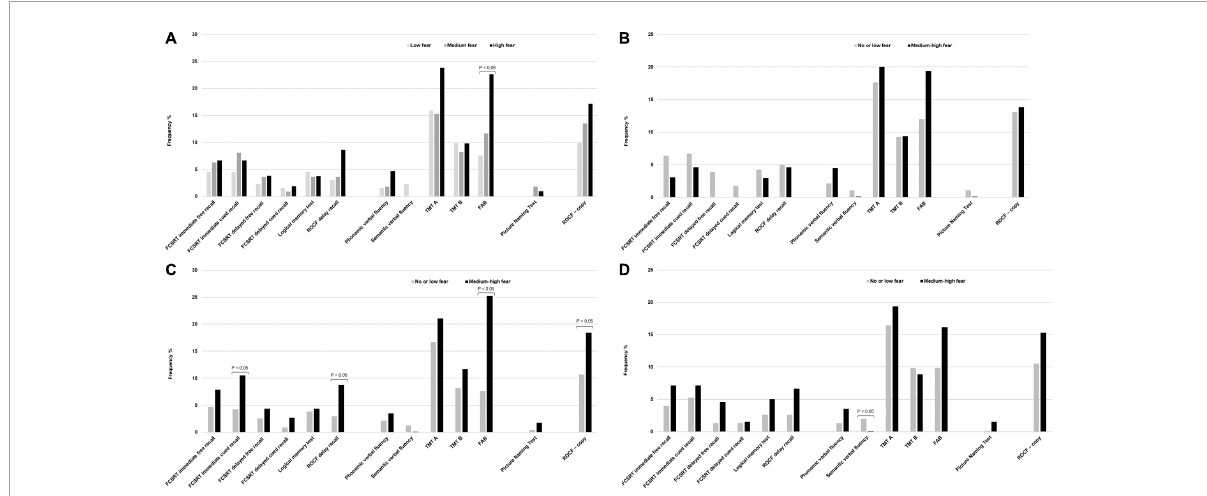
FIGURE1 (A) Frequency of impaired neuropsychological tests and tertiles of fear score. (B) Frequency of impaired neuropsychological tests and fear of contagion compared with peers. (C) Frequency of impaired neuropsychological tests and fear of contagion for themselves. (D) Frequency of impaired neuropsychological tests and fear of contagion for family members. P-value denotes a statistically significant difference between normal and impaired test at the 0.05 level, as derived from chi-squared tests. Data are percentages. FCSRT immediate free recall, Free and Cued Selective Reminding Test immediate free recall; FCSRT immediate cued recall, Free and Cued Selective Reminding Test immediate cued recall; ROCF delayed recall, Rey-Osterrieth Complex Figure Test delayed recall; TMT A, Trail Making Test A; TMT B, Trail Making Test B; FAB,